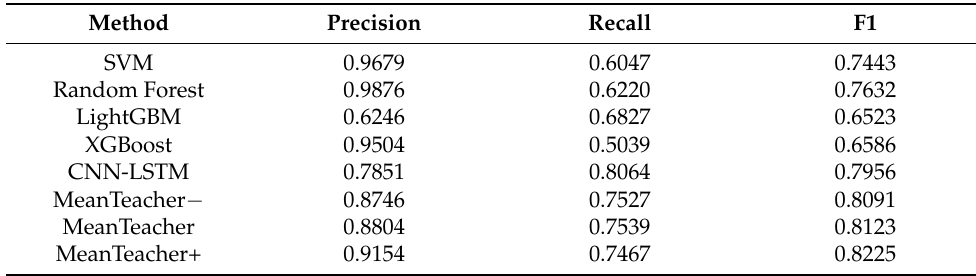
Table 5. Results of ablation experiments.